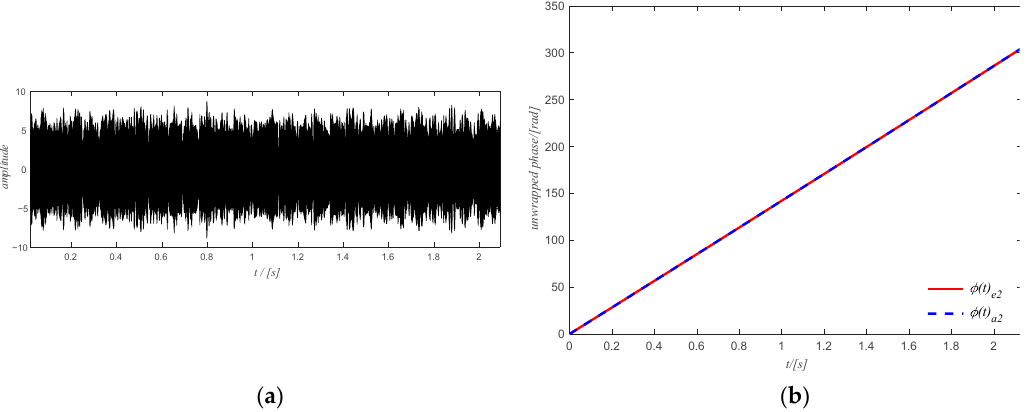
Figure 22. ( a ) The obtained time-domain signal of the filtered spectrum of case study 1; ( b ) the obtained shaft phase using the time domain signal.